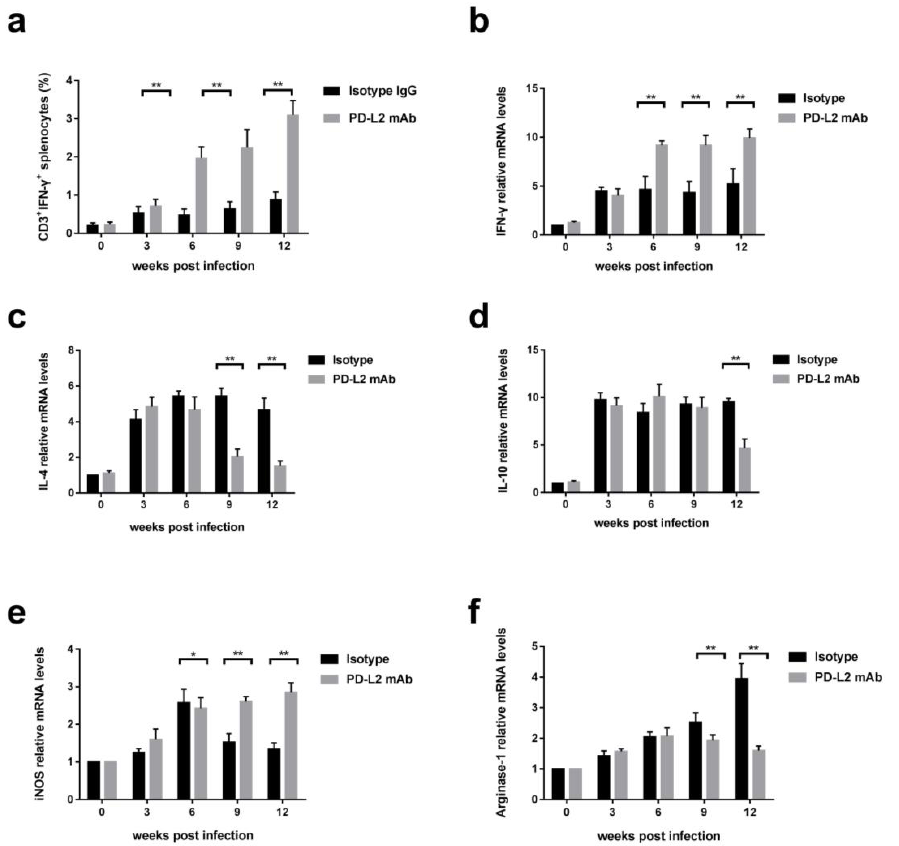
Figure 4. PD-L2 blockade increased inflammatory immune responses to C. hepatica infection in vivo. After being treated with PD-L2 monoclonal antibody, the percentage of CD3 + IFN- γ + T cells ( a ) was measured in splenocytes of mice infected with C. hepatica by flow cytometry. The mRNA expression levels of IFN- γ ( b ), IL-4 ( c ), and IL-10 ( d ) were measured in liver tissue by RT-qPCR, relative to the housekeeping gene β -actin. The transcriptional levels of iNOS ( e ) and Arginase-1 ( f ) were also measured in macrophages collected from liver tissue of mice upon treatment of PD-L2 antibody by RT-qPCR. Data are expressed as mean ± SEM from three independent experiments ( n = 5 mice per group). ** p < 0.01; * p <